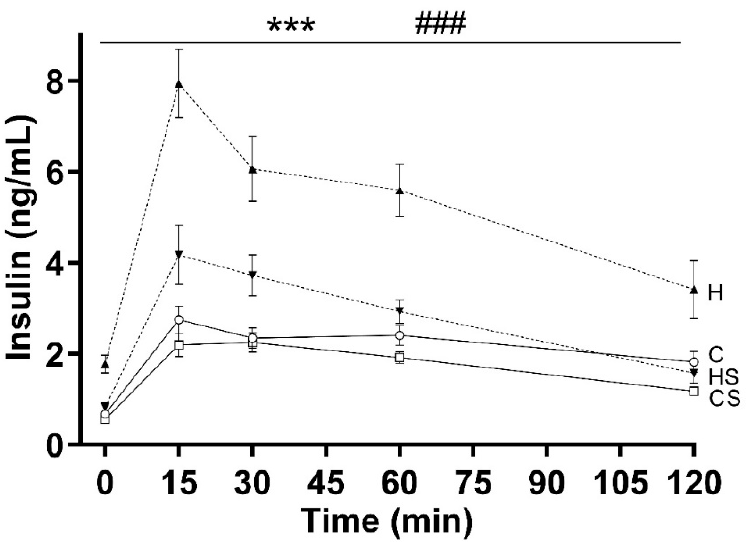
Figure 5. Insulin levels during OGTT. Data are shown as mean ± SEM ( n = 15 per group) in rats consuming C (solid lines and open circle), CS (solid lines and rectangle), H (dotted lines and upright triangle) and HS (dotted lines and inverted triangle) diets. Abbreviations: C, Control diet; CS, Control diet with supplement; H, HFD; and HS, HFD with supplement. Effects of HFD and supplement were assessed by repeated measures two-way ANOVA followed by LSD post hoc. There was an interaction effect ( p < 0.01) of HFD and supplement for the insulin release during OGTT. Overall HFD effect *** p < 0.001. Overall supplement effect ### p <